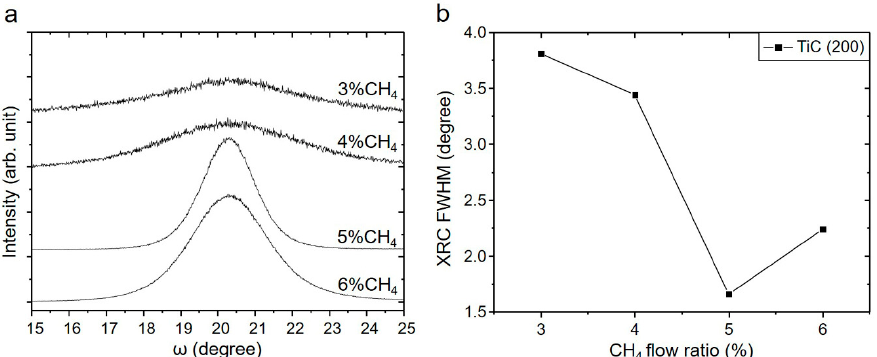
Figure 3. ( a ) X-ray rocking curves (XRC) of TiC 200 reflection for different CH 4 flow ratios and ( b ) variation of the XRC full width at half maximum (FWHM) with CH 4 flow ratio.